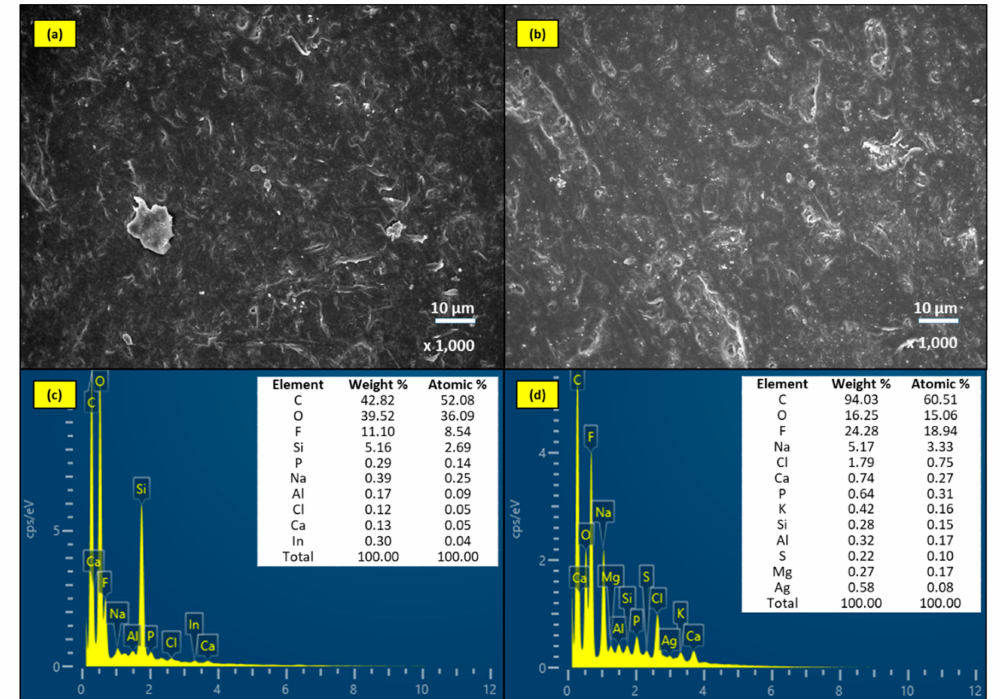
Figure 7. The images of SEM and EDS spectra of ( a , c ) unmodified membrane and ( b , d ) AgNPs-MF membrane after 60 days in submerged